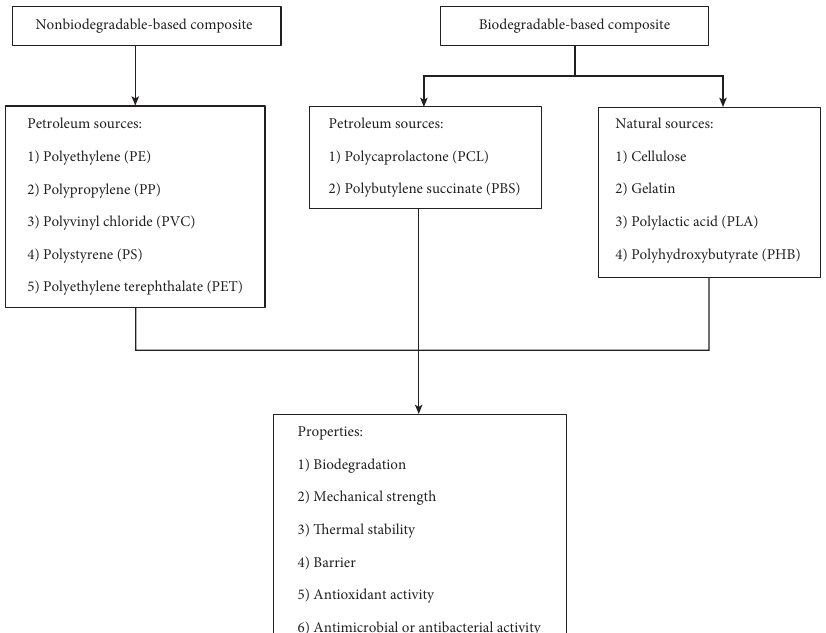
Figure 2: Workflow overview of this study.